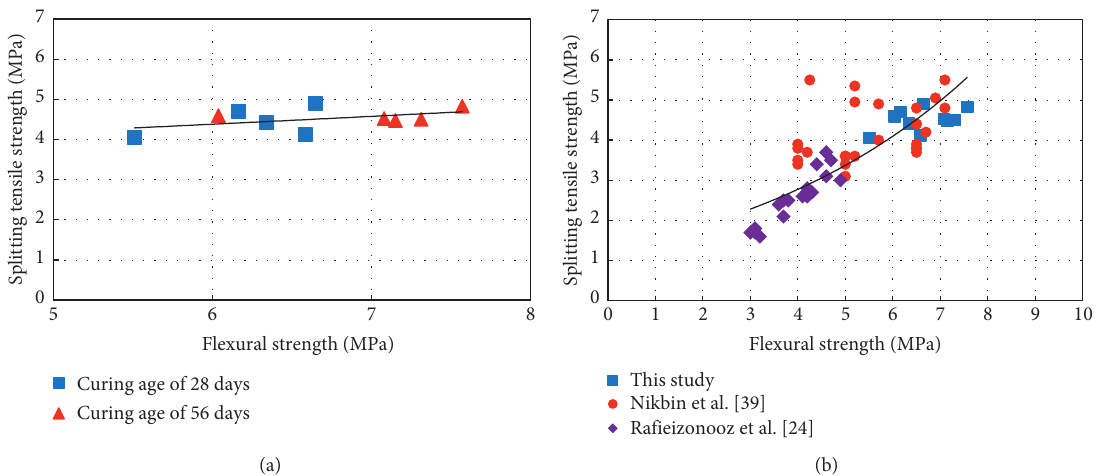
Figure 11: Relationship between the splitting tensile strength and flexural strength. (a) Test results in this study. (b) Test results in this study and previous studies.